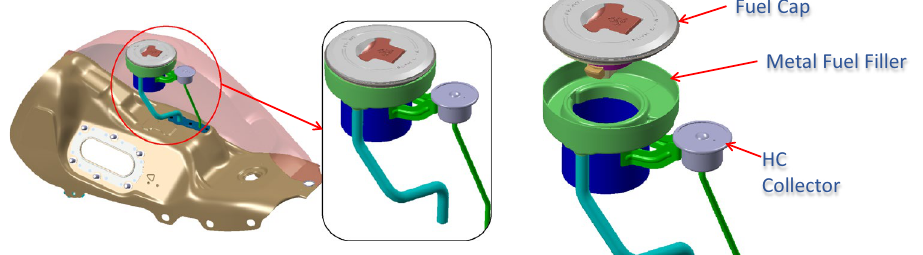
Figure 11. Final solution for fuel cap.